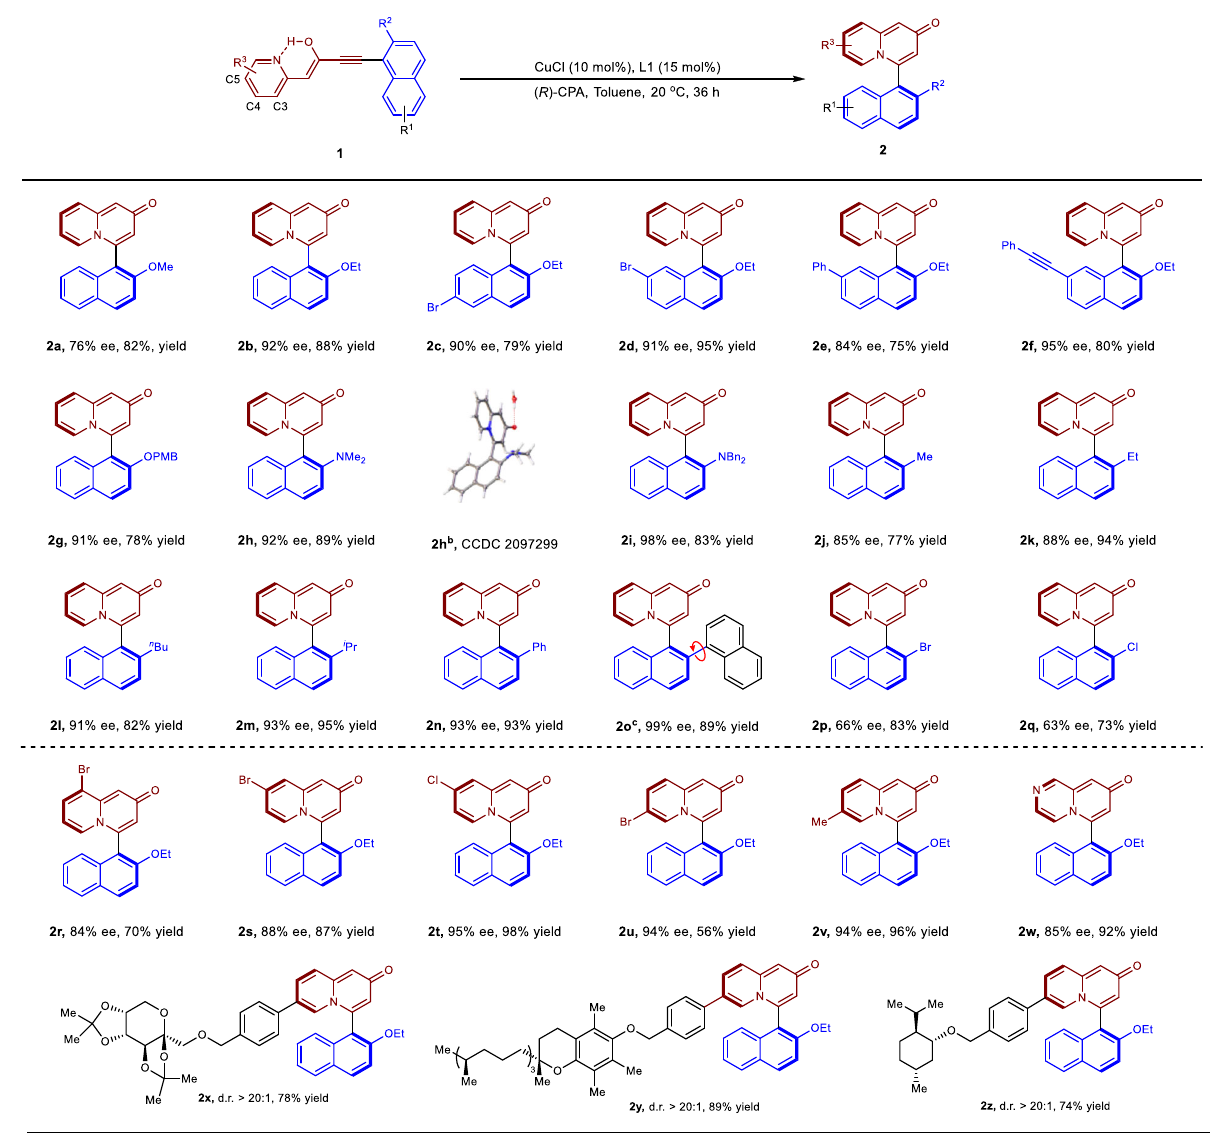
Fig. 2 Substrate scope of the reaction. Reaction conditions: 1 (0.1 mmol), CuCl (10 mol%), L1 (15 mol%), ( R )-CPA (0.1 mmol), toluene (2.0 mL), 20 °C for 36 h. The yield of isolated products. Ee values were determined by chiral HPLC. OPMB = p -methoxybenzyl b . The single-crystal X-ray of 2h contains one molecule of H 2 O c . There are conformers that existed around the red